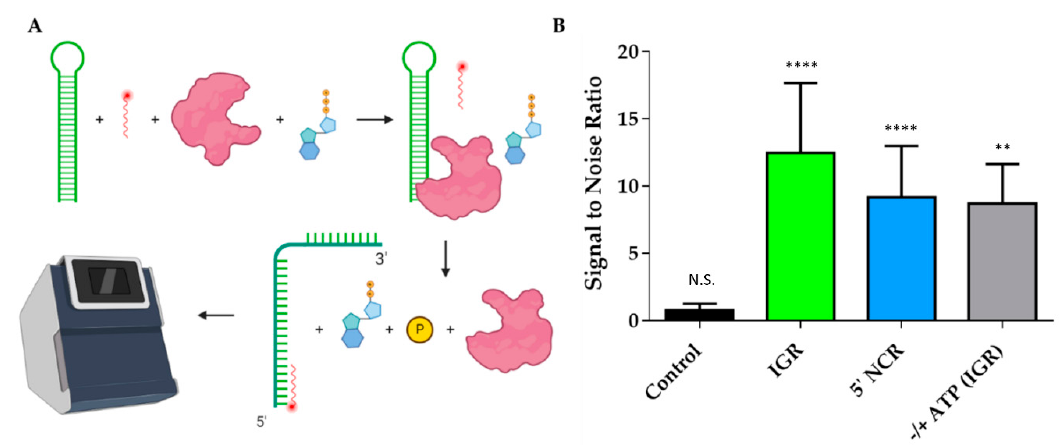
Figure 7. DDX17 135–555 helicase assays performed using MST. ( A ) Representation of helicase assay using MST. The helicase assay was performed by combining the RNAs, fluorescently labeled DNA oligo, DDX17 135–555 , and ATP. DDX17 135–555 hydrolyzes the ATP and unwinds the RNA, giving the oligo access to the newly opened complimentary site. The fluorescently labeled DNA oligo hybridized to the RNA can be measured in the MST by detecting the change in migration. This is compared to a control that uses bovine serum albumin (BSA) instead of DDX17 135–555 , and a change in the migration indicates that the RNA has been unwound by DDX17. ( B ) Signal to noise ratios of different comparative assays (n = 3). Control compared a reaction mix without protein to BSA, signal to noise did not meet the threshold of 5 and was not significant, unpaired t -test ( p = 0.9350, N.S.). DDX17 135–555 caused a significant change in the IGR ( p < 0.0001, ****), with the signal to noise ratio reaching 12.5. The 5’ NCR also experienced a significant shift in the presence of DDX17 135–555 ( p < 0.0001, ****), having a signal to noise ratio of 9.17. Gray bar represents including ATP vs. not including ATP in the reaction mixture, showing ATP causes a significant change in fluorescent migration, having a signal to noise of 8.70 ( p = 0.0059, **) .